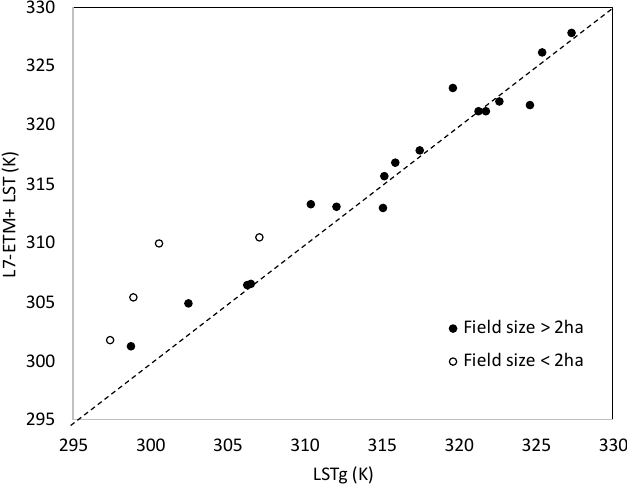
Figure 7. Linear adjustment between L7-ETM + estimates and ground-measured LST values. Data collected in Sites 1.1 and 1.2 (field extension < 2 ha) are labeled with non-filled dots. Dashed line represents the 1:1 agreement.